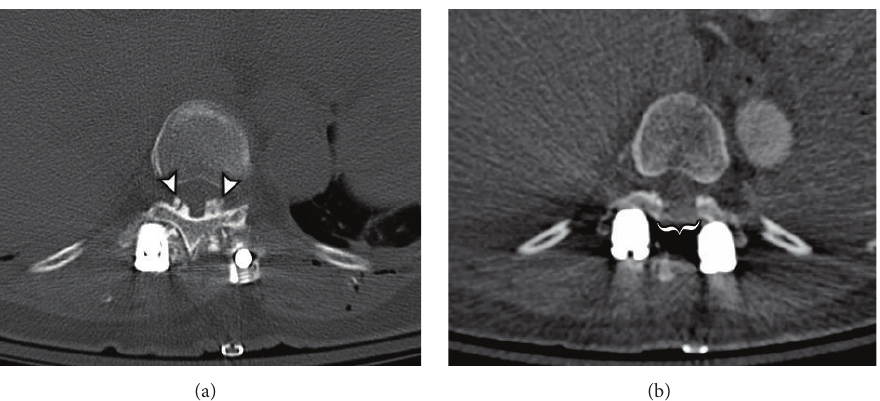
Figure 3: Postfacetectomy (a) and postlaminectomy (b) axial Computed Tomograms at the level of T10-11. The arrowheads in (a) demonstrate bilateral ossifications of the ligamentum flavum occupying the posterior aspect of the spinal canal. The bracket in (b) indicates the area where decompression was achieved via laminectomy and resection of these lesions.